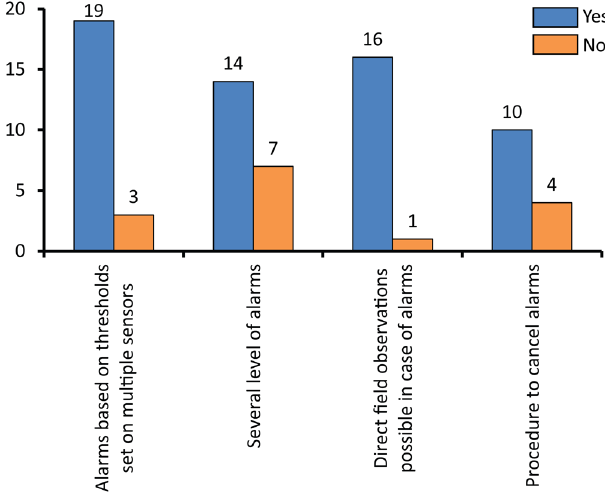
Fig. 10. Inventory of the essential characteristics of alarm proce- dures for the 23 reported monitoring networks.